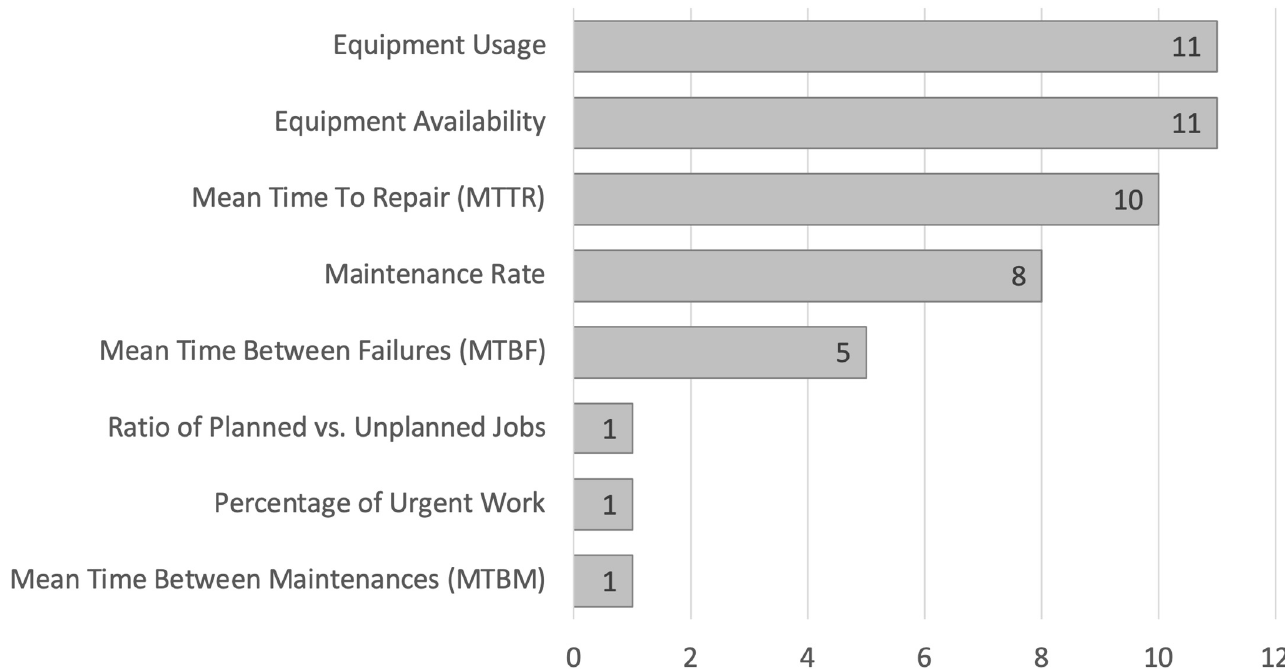
Figure 2. Mining KPIs by number of mines (out of 12) found by Lafontaine [18].